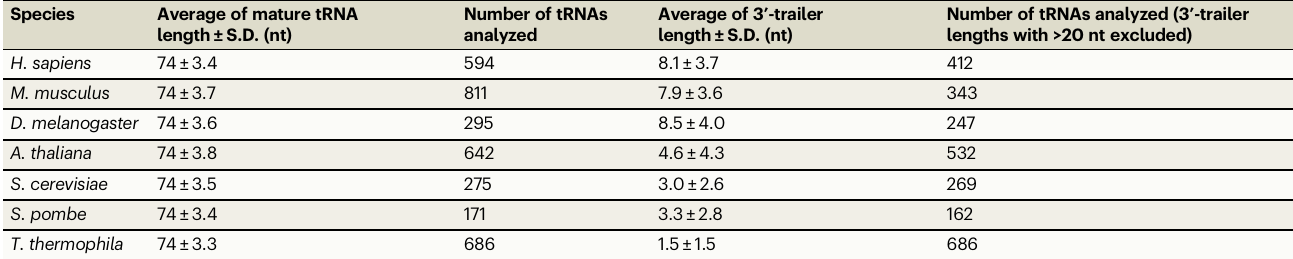
Table 2 | Summary of 3 ’ -trailer and mature tRNA sequence lengths in different eukaryotic species Species Average of mature tRNA length±S.D.